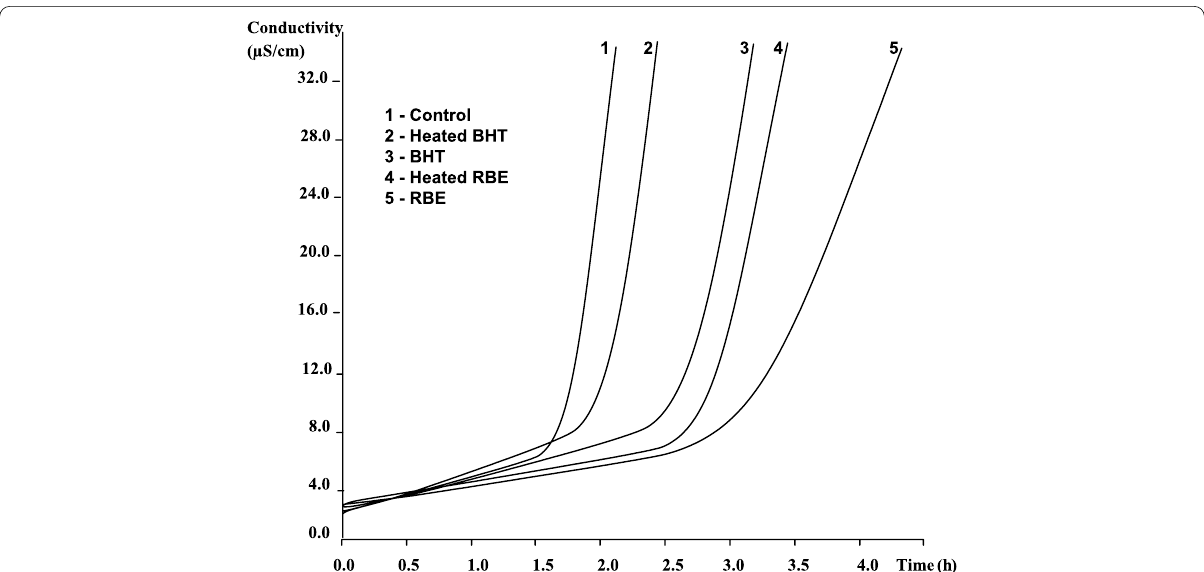
Fig. 1 Rancimat curves for the formation of oxidation products in sunflower oil with non-heated antioxidants, heated antioxidants and control with no antioxidants